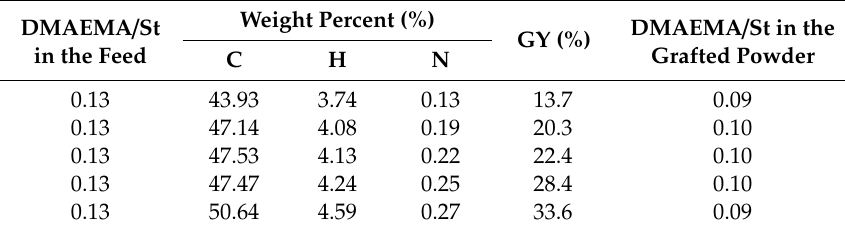
Table 1. The elemental analysis (EA) of the PVDF- g -P(St- co -DMAEMA) powders with different GYs. Weight Percent (%) DMAEMA/St in the Feed GY (%) DMAEMA/St in the Grafted Powder C